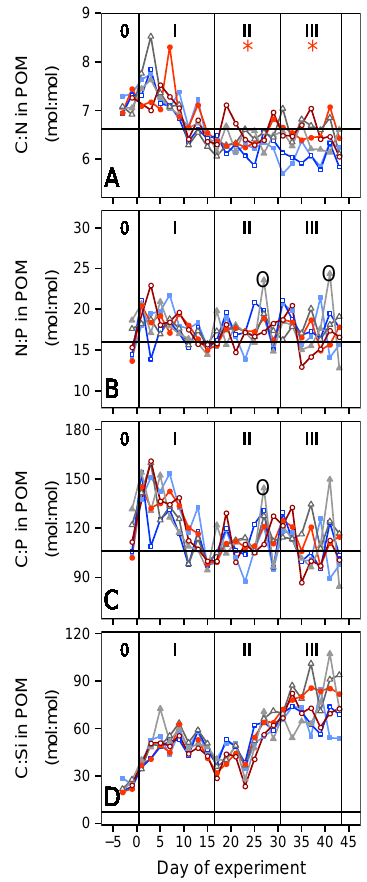
Figure 13. Temporal dynamics of elemental stoichiometry in particulate organic matter: (a) carbon to nitrogen, (b) nitro- gen to phosphorus, (c) carbon to phosphorus, (d) carbon to biogenic silica. Horizontal lines indicate Redfield stoichiometry (C:N:P:Si = 106:16:1:15; Redfield, 1958). Colours and sym- bols for different treatments are described in Table 1. Red aster- isks denote significant positive effect of CO 2 (* = p <0.05). Out- liers (Grubb’s test; see methods) are indicated by black circles and were excluded from linear regression